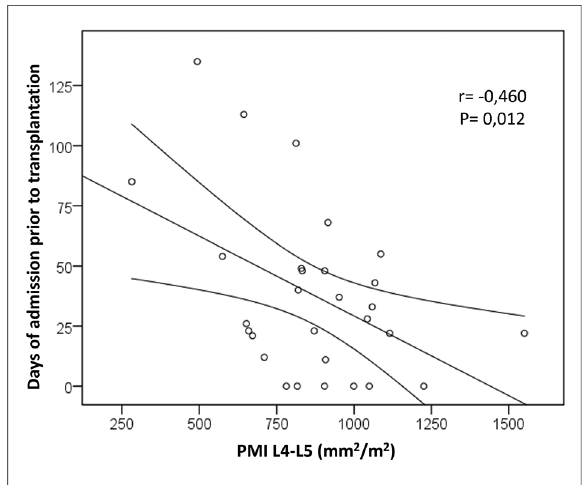
FIGURE 2 Correlation of psoas muscle mass with pre-transplantation variables. A bivariate negative correlation was found between psoas muscle index (PMI) measured at L4-5 level and the days of admission prior to liver transplantation.